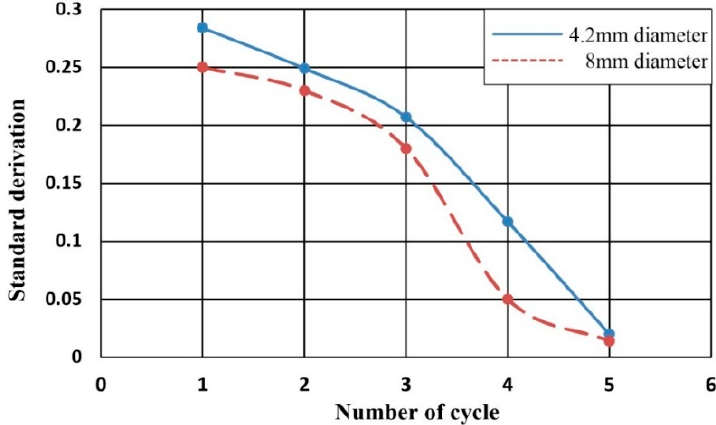
Figure 10. The standard deviation of the mixing performance with two different pin sizes.